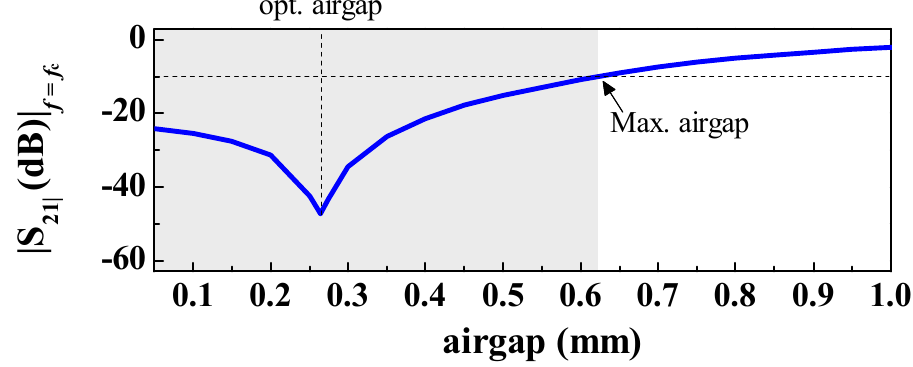
Figure 2. Layout of the SRR-loaded microstrip line of the reader ( a ), and transmission coefficients with and without oppositely oriented SRR on top of it ( b ). Dimensions are (in mm): l 1 = 3.16, l 2 = 3.35, s 1 = 0.2, s 2 = 0.2, W 1 = 0.56, and W 2 = 0.5. The considered air gap is 0.25 mm. The substrate of the line is the Rogers RO3010 with thickness h = 0.635 mm and dielectric constant ε r = 10.2. The substrate of the tag is the Rogers RO4003C with thickness h = 0.204 mm and dielectric constant ε r = 3.55. Figure extracted from Herrojo et al. [55]; printed with permission.